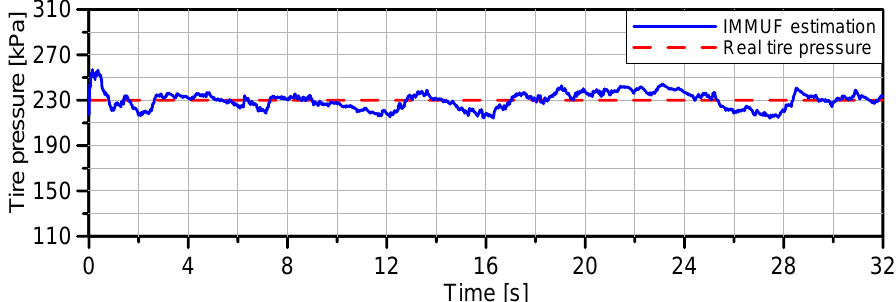
Figure 13. Estimation of tire pressure with experimental